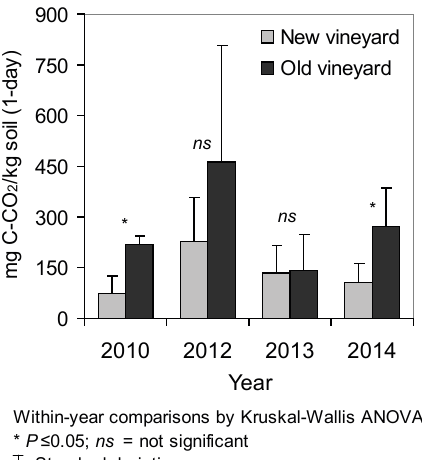
Figure 4. Dendrograms of hierarchical cluster analysis based on UPGMA and Dice’s coefficient of DGGE banding patterns of the 16S rDNA.